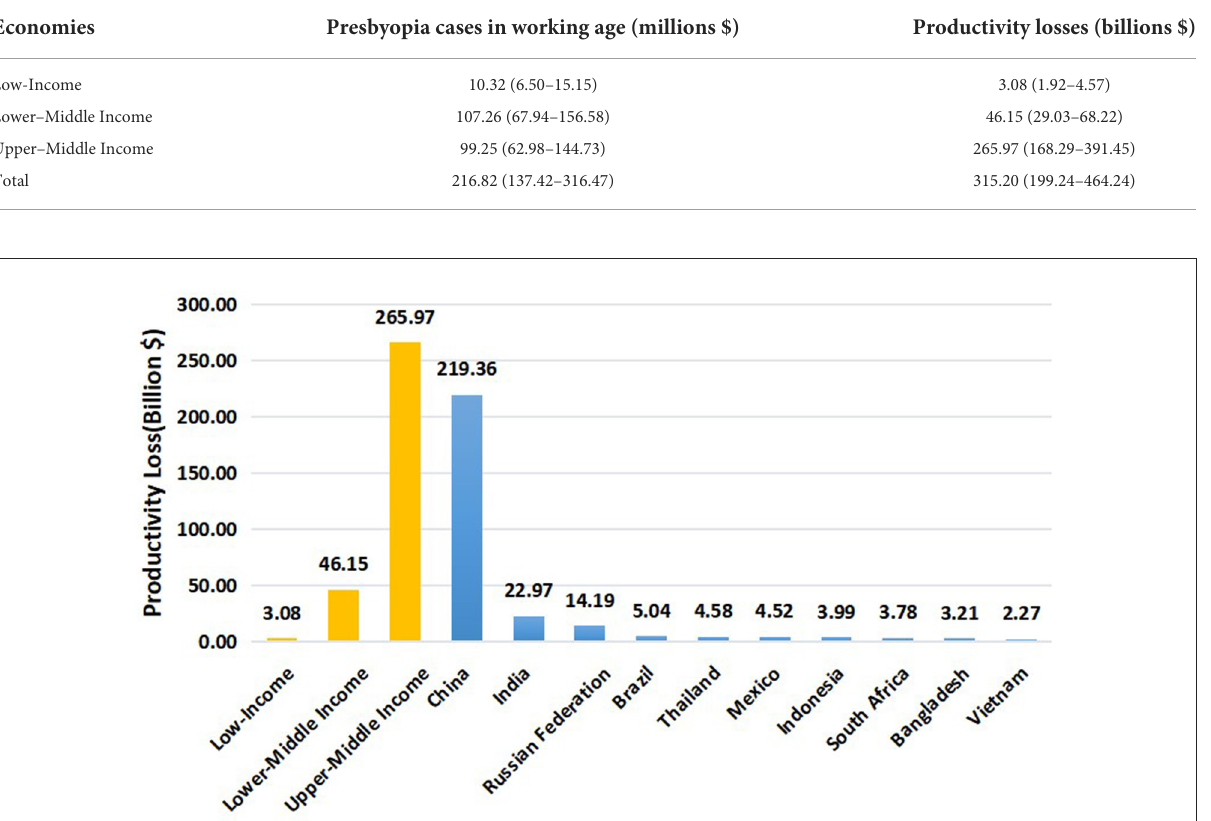
TABLE 3 Productivity losses of presbyopia cases in LMICs from 2019 to retirement age.